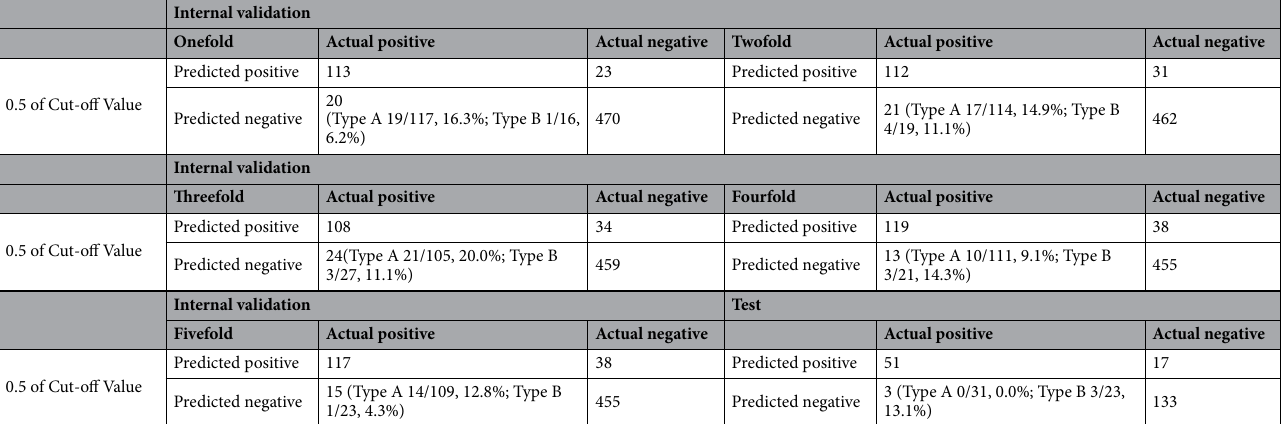
Table 2. Diagnostic performance matrix. Fivefold validation was performed with the dataset from hospital A and B. A hard voting method was used with five models from fivefold cross-validation to obtain the final